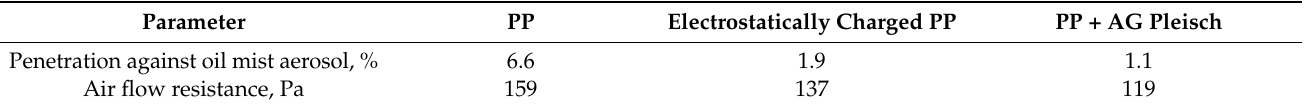
Table 2. Summary of basic protective and operational parameters for filtering and filtering–absorbing materials for use in smog half